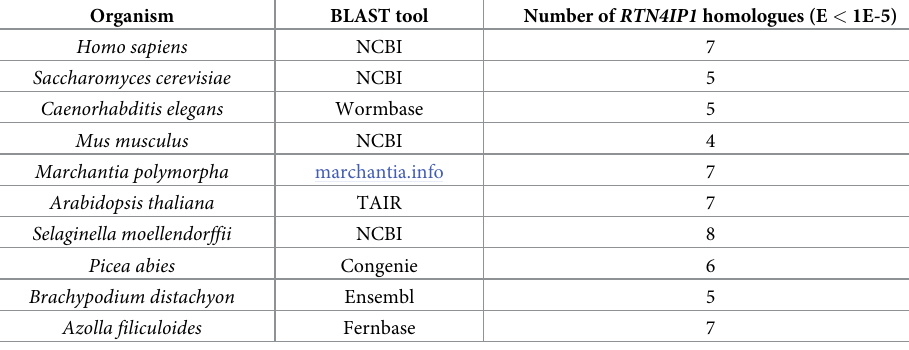
Table 1. Species included in the phylogenetic analysis of RTN4IP1 homologues.